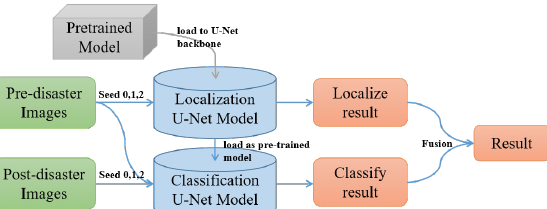
Figure 2. Overall framework of model training and